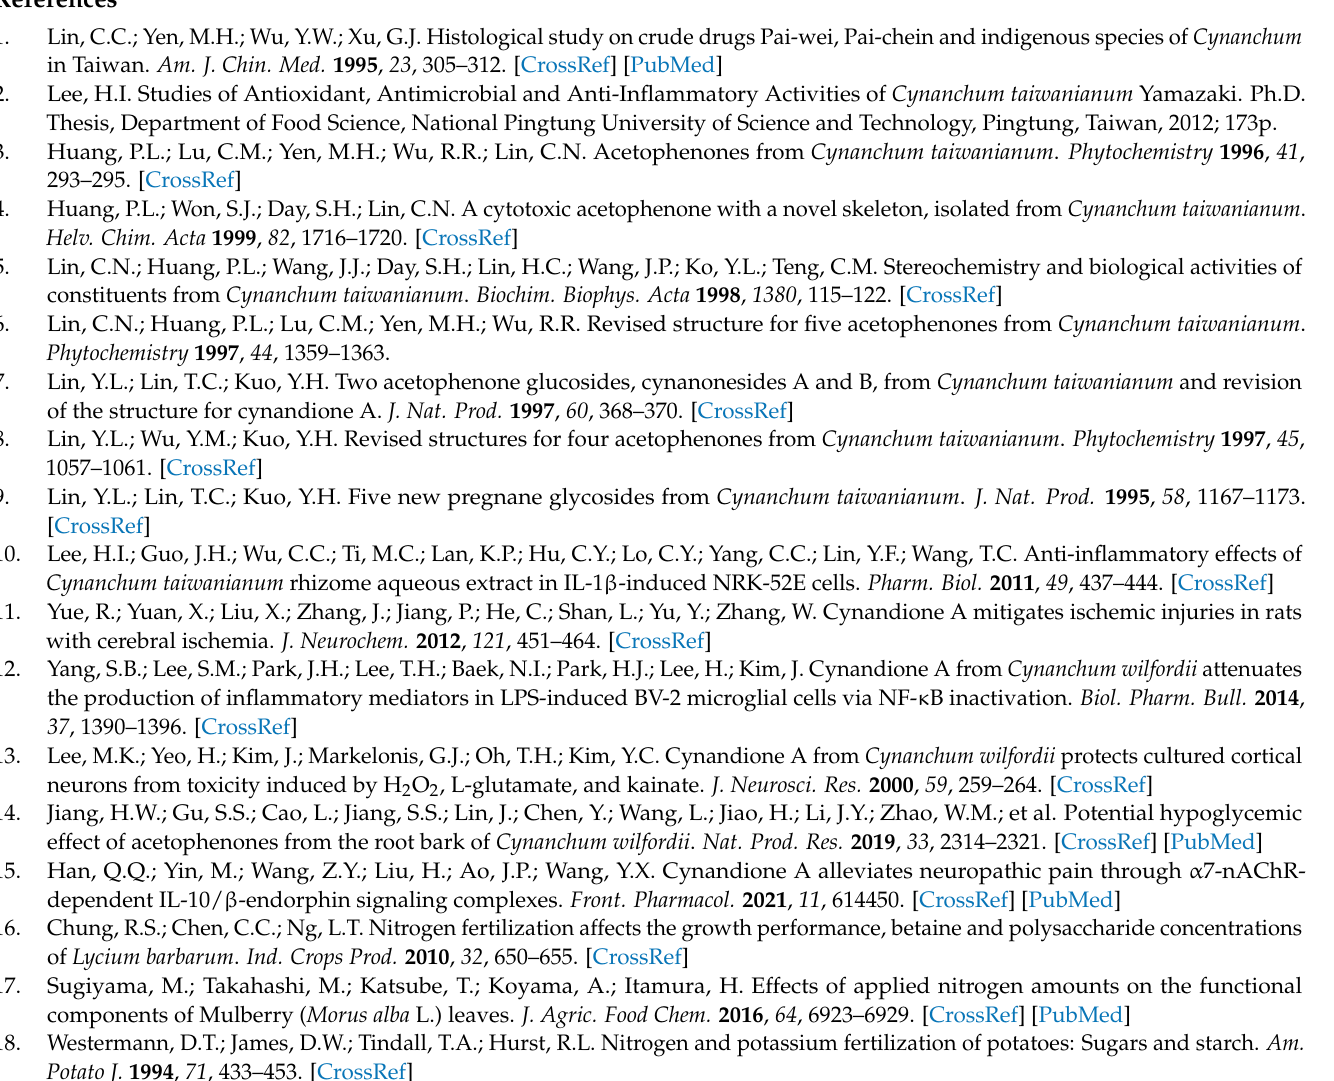
Table S1: Design of different fertilizer treatments in field